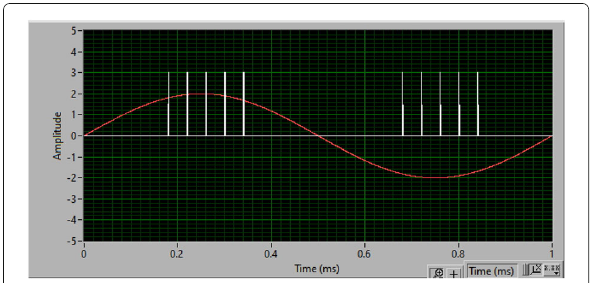
Fig. 2 LFAC waveform at 1 Hz and sync pulses generated. The sync pulses were phased to trigger at the peaks of the sinusoidal